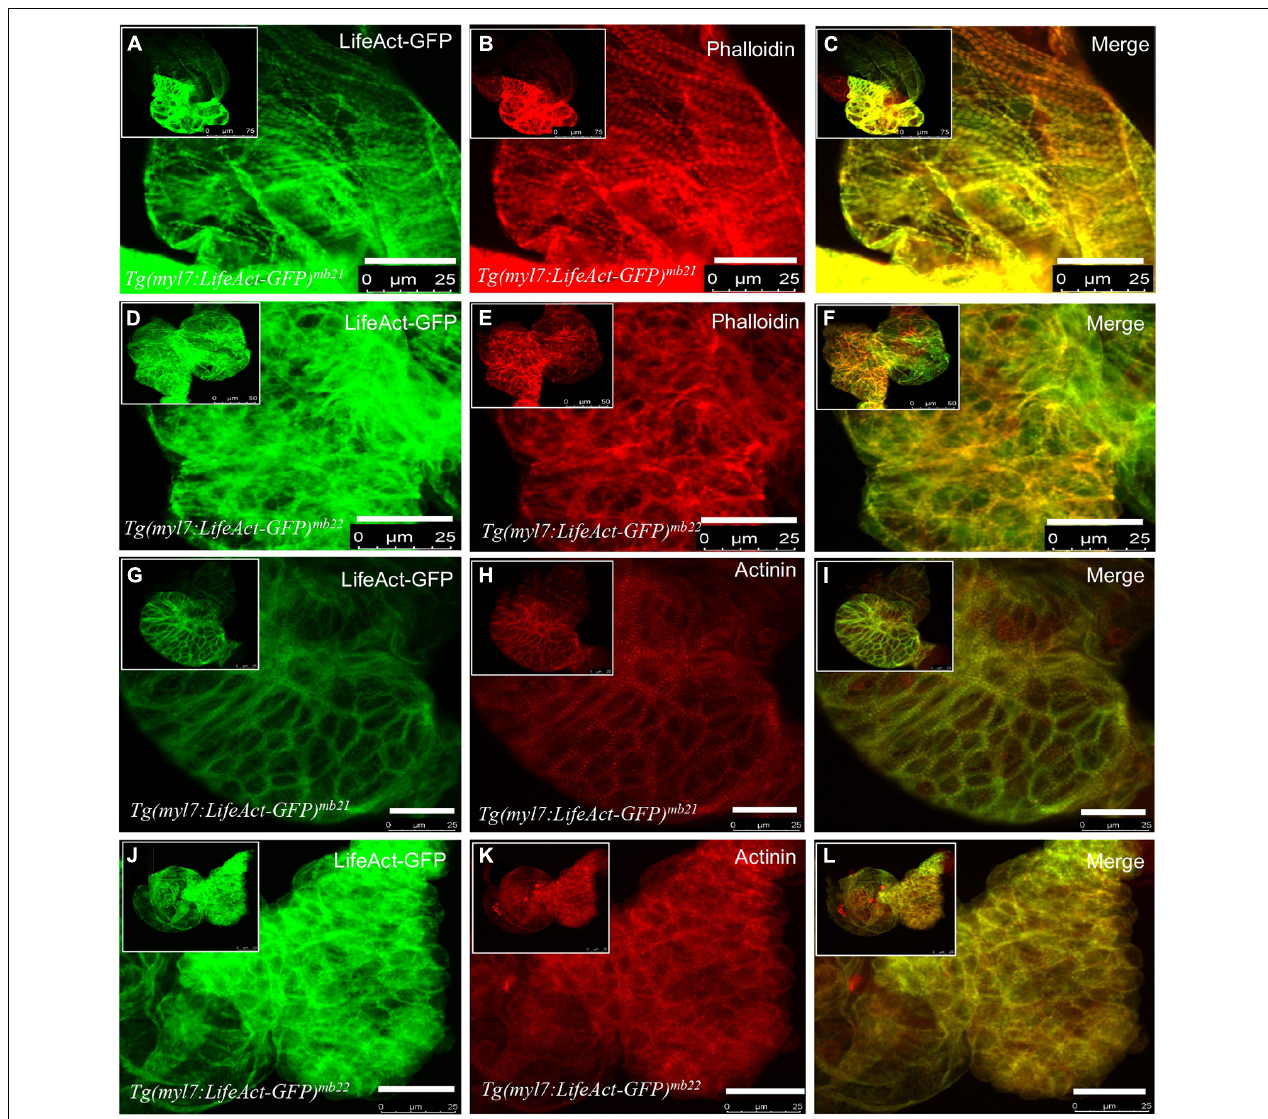
FIGURE 3 | The effect of Lifeact-GFP expression on actin filament and sarcomere organization in cardiomyocytes of Tg(myl7:Lifeact-GFP) mb 21 and Tg(myl7:Lifeact-GFP) mb 22 transgenic embryos. (A–F) Actin think filaments revealed by Lifeact-GFP (A,D) and phalloidin staining (B,E) in Tg(myl7:Lifeact-GFP) mb 21 (A–C) , and Tg(myl7:Lifeact-GFP) mb 22 (D–F) transgenic embryos at 72 hpf. (C,F) are merged pictures of A-B and D-E, respectively. (G–L) The sarcomeric organization of actin think filament and Z-lines revealed by Lifeact-GFP (G,J) anti- α -actinin antibody staining (H,K) in Tg(myl7:Lifeact-GFP) mb 21 (G–I) , and Tg(myl7:Lifeact-GFP) mb 22 (J–L) transgenic embryos at 72 hpf. (I,L) are merged pictures of (G,H,J,K) , respectively. Scale bars: 25 µ